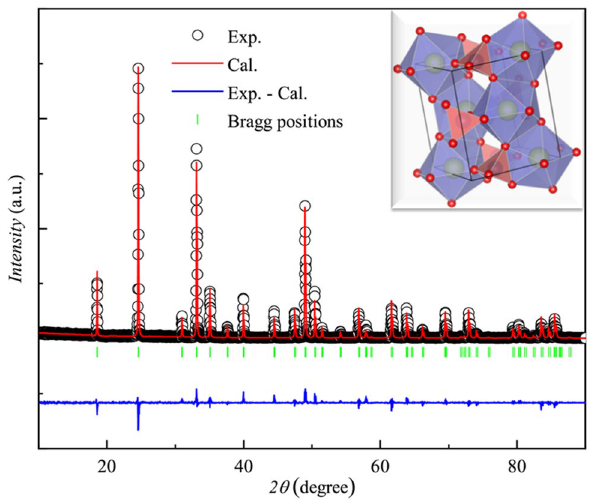
Figure 1. Rietveld refined powder-XRD pattern of TbVO 4 obtained at room temperature. The black open circles indicate the experimental data, while the Rietveld refinement fit is shown as solid red line. The solid blue line and green vertical lines show the difference curve and Bragg positions, respectively. The inset shows its crystal